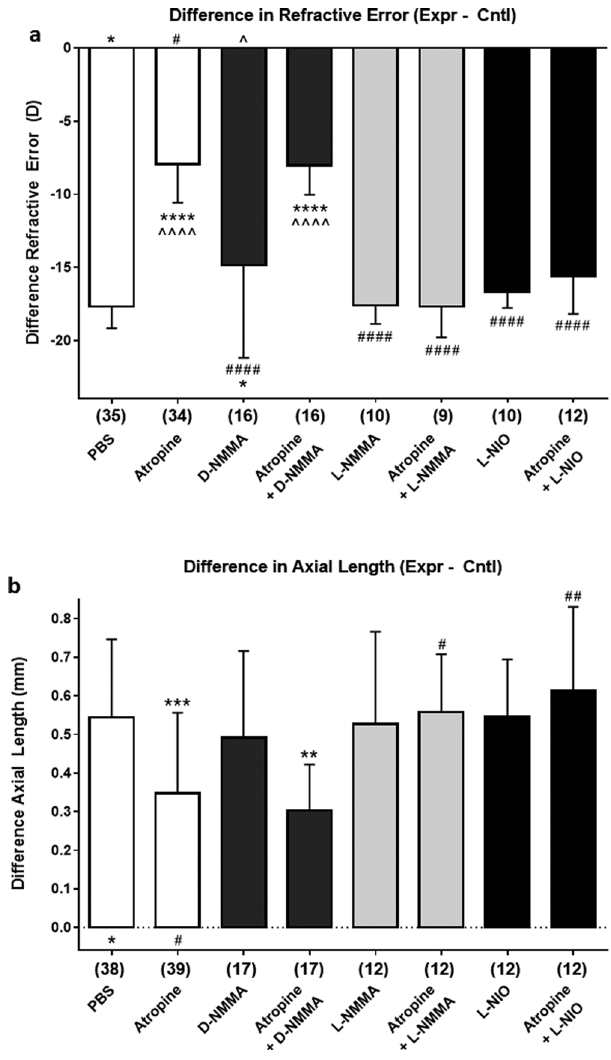
Figure 5. The effects of atropine (240 nmol), NOS inhibitors (6 nmol; L-NIO, L-NMMA), D-NMMA (6 nmol), and the combination of atropine + NOS inhibitors (L-NIO, L-NMMA), or atropine + D-NMMA on refractive error ( a ) and axial length ( b ); treatment schedule as in Fig. 1. Abbreviations: L-NIO [N G -(1-Iminoethyl)-L- ornithine]; L-NMMA [L-N G -monomethyl arginine]; D-NMMA [D-N G -monomethyl arginine]. Symbols: asterisk ( * ): comparison to effect of PBS-treatment; pound (#): comparison to effect of atropine-treatment; caret (^): comparison to effect of D-NMMA-treatment. Statistics: •••• p < 0.0001, ••• p < 0.001, •• p < 0.01, • p < 0.05; One-Way ANOVA + Tukey’s post-hoc. Data are represented as the means of the difference in values for the experimental eye minus those for the control eye, ± SD; sample sizes (n) are denoted in brackets below each